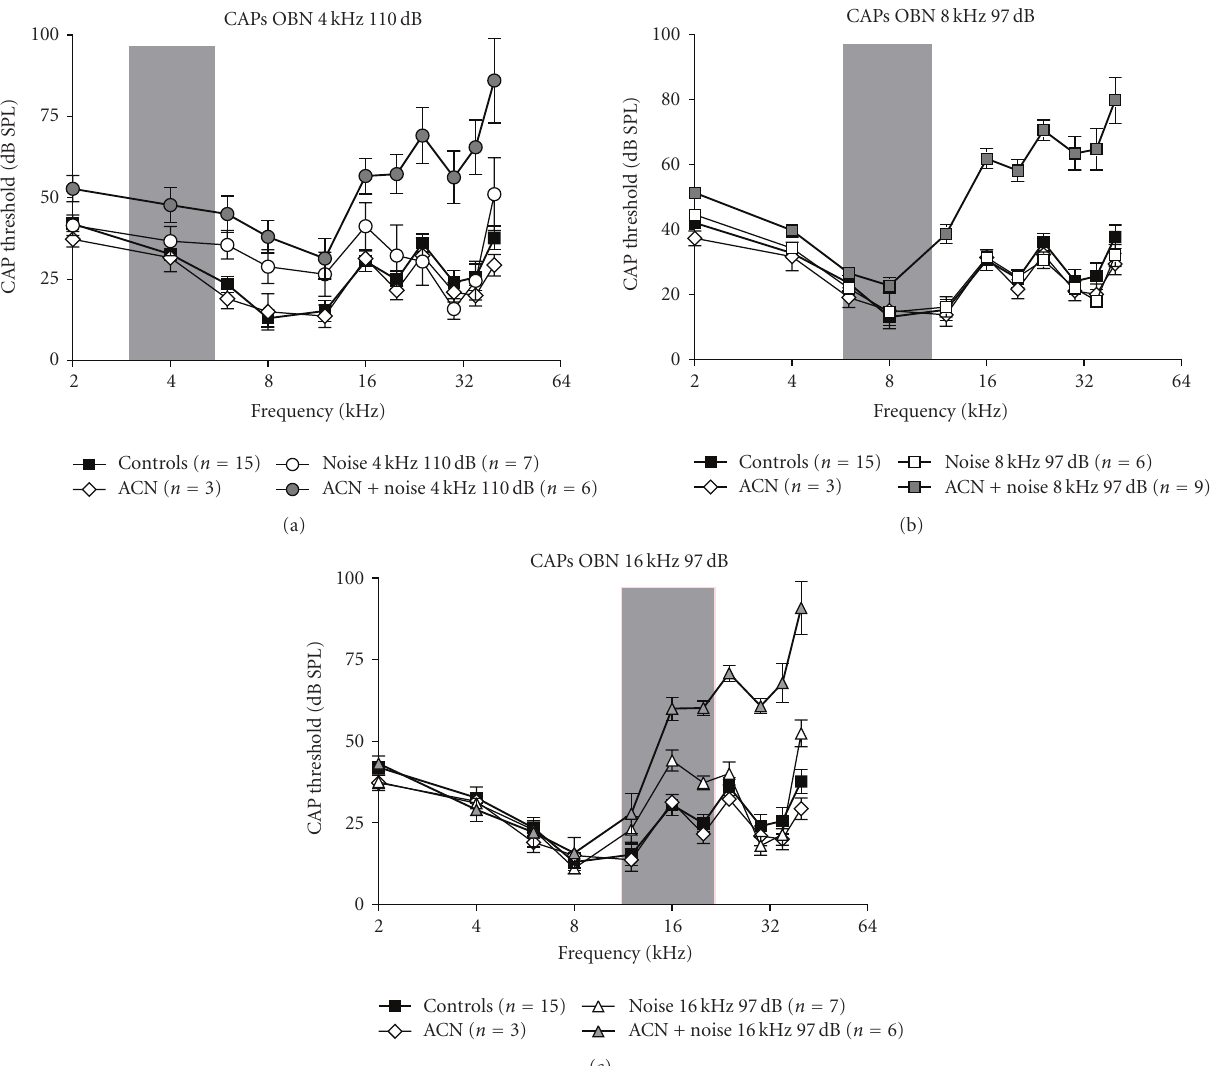
Figure 3: E ff ects of the di ff erent experimental treatments on compound action potential (CAP) thresholds measured 4 weeks post-exposure for frequencies ranging from 2 to 40 kHz. CAP thresholds obtained in rats exposed to (a) the 110 dB OBN-4kHz with or without ACN, (b) to the 97 dB OBN-8kHz with or without ACN, or (c) to the 97dB OBN-16kHz with or without ACN (see Table 1 for details). Auditory thresholds measured in control and ACN alone animals were included in each of the graphs for reference. The colored areas represent the octave band-noise frequency ranges. Error bars: ±